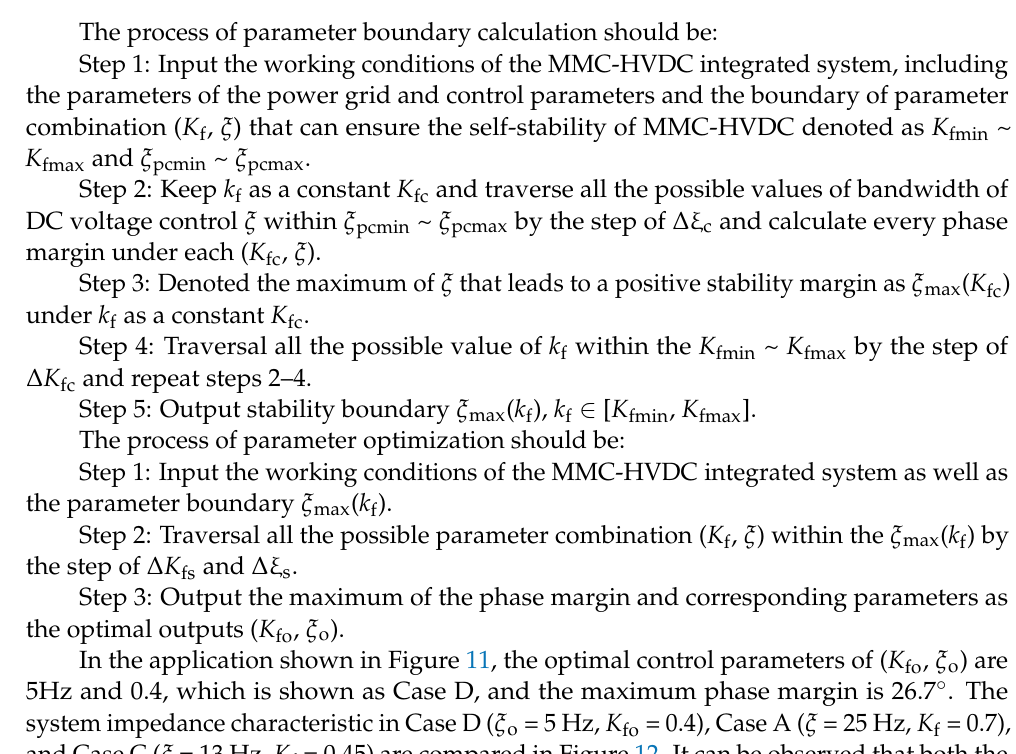
Figure 12. Impedance characteristics of the MMC-HVDC system before and after